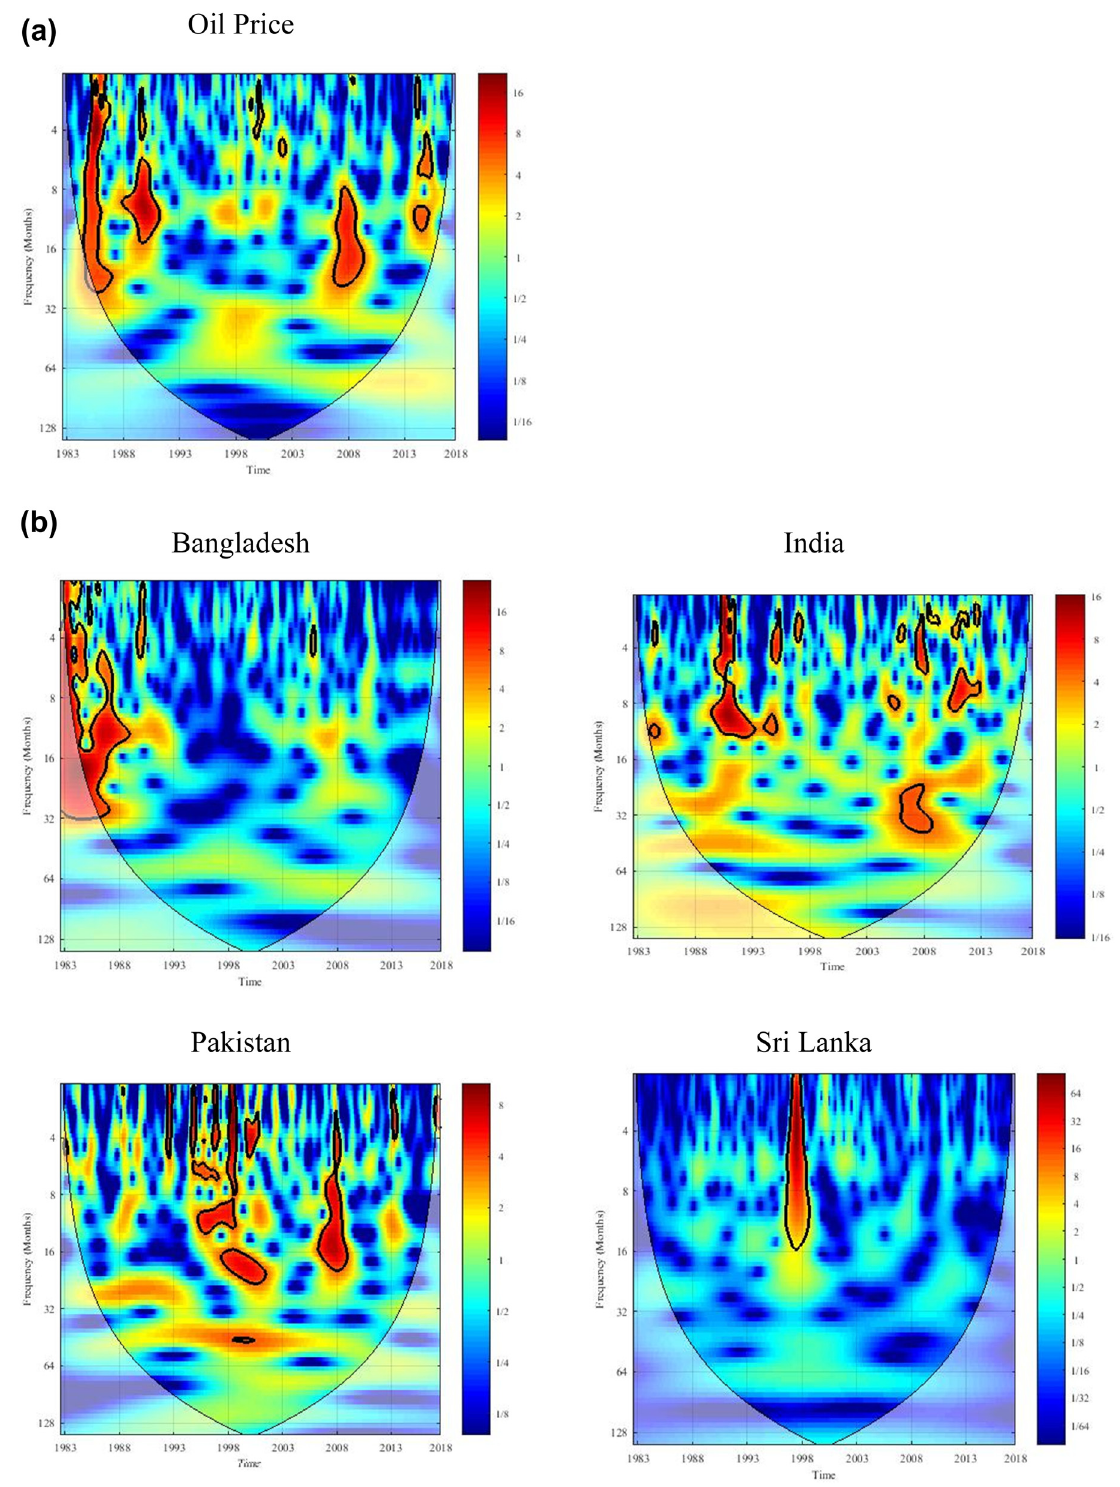
Figure 1: CWT power spectrum of ( a ) oil price and ( b ) exchange rates. Note: Signi fi cance level at 5% is shown as thick black contour. Blue ( red ) color shows low ( high ) power. X - axis provides time period, while Y - axis provides frequency ( in months )